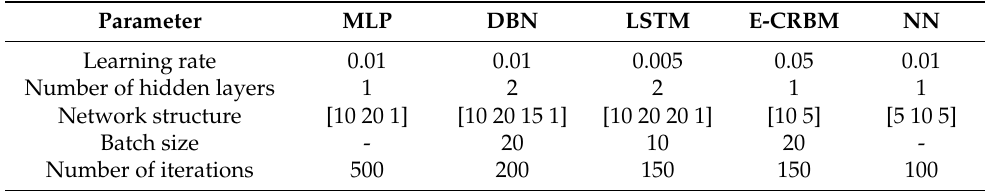
Table 1. Parameter setting of each